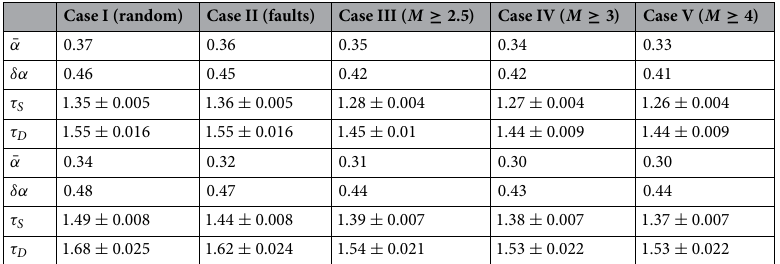
Table 1. Upper Table: The values of exponents ¯ α , δα , τ S , and τ D for the dynamics with avalanches in the whole space, wherein the δα is defined as the width of f (α) , which is the length of the interval between two successive f (α) = 0.3 . Lower Table: The same for the dynamics with avalanches inside the high-resolution